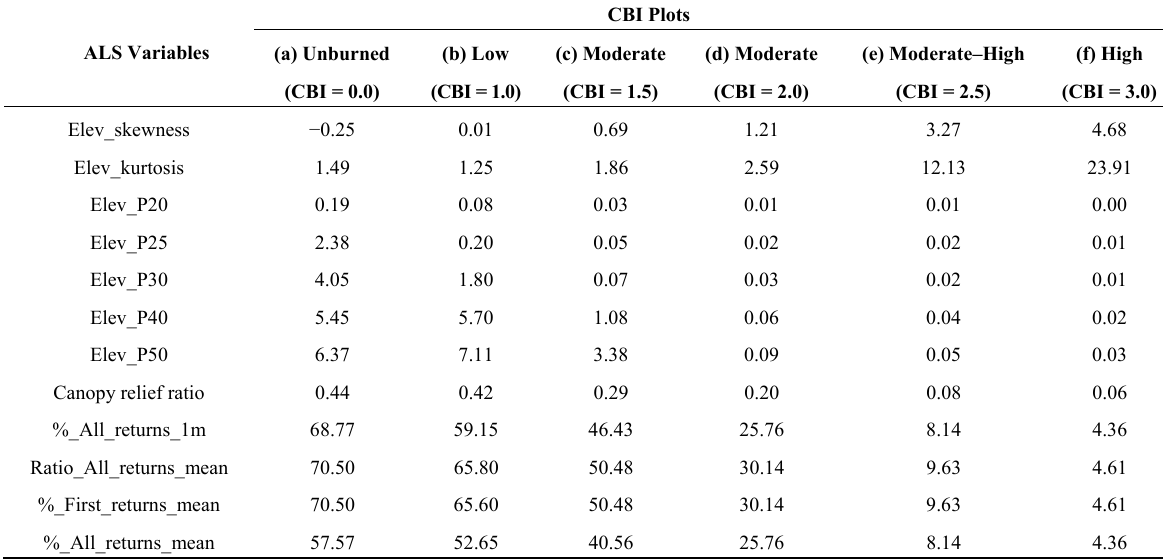
in Figures 4 and 5.